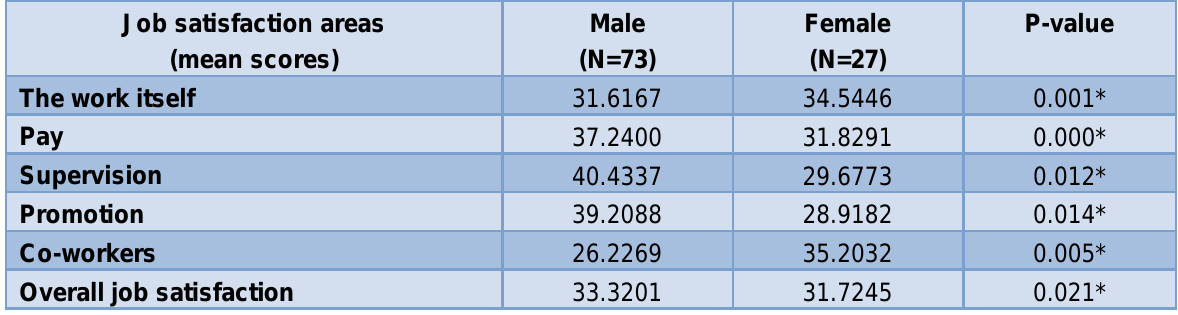
Table 3 Differences in Job satisfaction means based on Gender (N=100) (T-test) * Denotes significant differences among groups at the 0.05 level